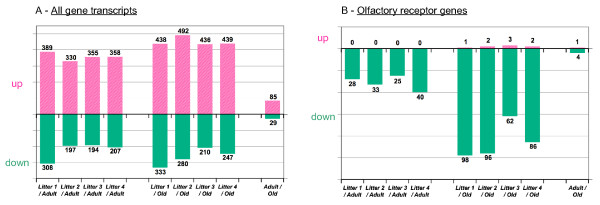
Up- and down-regulated transcripts and OR genes. Numbers of up- and down-regulated transcripts and OR genes (fold change ≥ 5) identified by pair-wise comparisons between age groups.